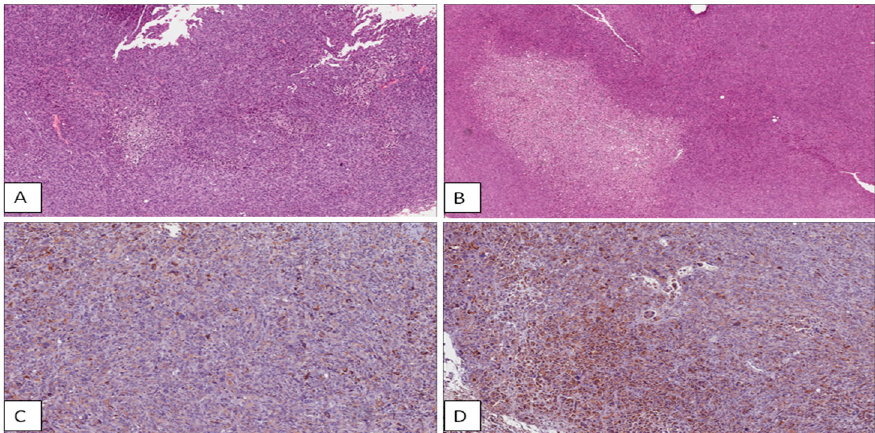
Figure 2. Representative slides of hematoxylin / eosin (H&E) and immunohistochemical staining. ( A ) Small necrosis foci after 10 days post-PT (proton therapy) with the dose of 9 Gy; ( B ) extensive necrosis after 72 h post-PT with the dose of 9 Gy; high immunohistochemical expression of caspase-3 ( C ) and CD133 ( D ) in tumor after 72 h post-PT with the dose of 9 Gy. In addition, the apoptotic count showed a slight increase with dose escalation in both the time window of 72 h and 10 days post-treatment. In order to understand the reduction of necrotic foci and cleaved CASP3 expression with higher doses in samples observed 10 days post-PT, we assessed the CD68, as a macrophage marker. Indeed, its positivity was found only in samples analyzed 10 days after PT, with higher scores just in the 9 Gy treated sample, rendering evident the scavenger e ff ect by these cells, able to eliminate dead tumor cells and